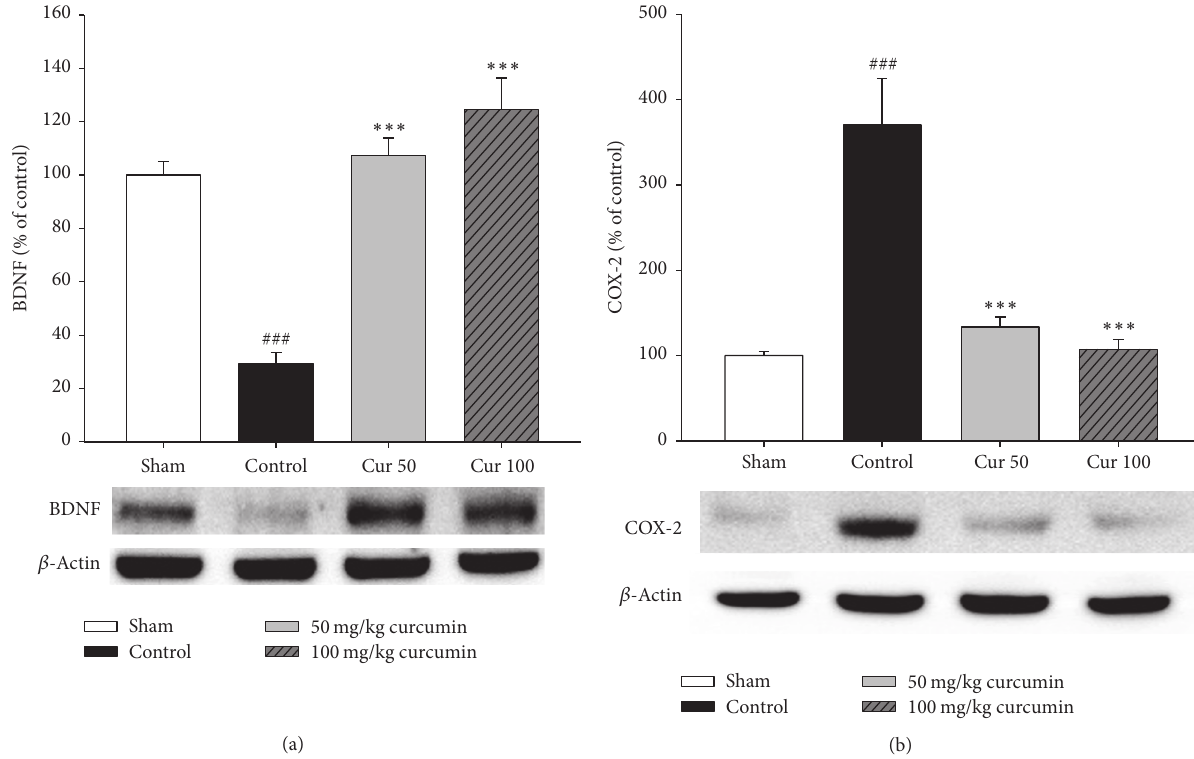
Figure 2: Effect of curcumin on the protein expression of brain-derived neurotrophic factor (BDNF) and cyclooxygenase-2 (COX-2) in rats with chronic stress-induced hippocampal impairment ( 𝑛 = 4 /group). (a) The protein level of BDNF in rat hippocampus was measured by Western blot analysis using anti-BDNF specific antibody. (b) The protein level of COX-2 in rat hippocampus was measured by Western blot analysis using anti-COX-2 specific antibody. The data were normalized against 𝛽 -actin levels and expressed as percentage of control values. ### 𝑝 < 0.001 versus sham group. ∗∗∗ 𝑝 < 0.001 versus control group.